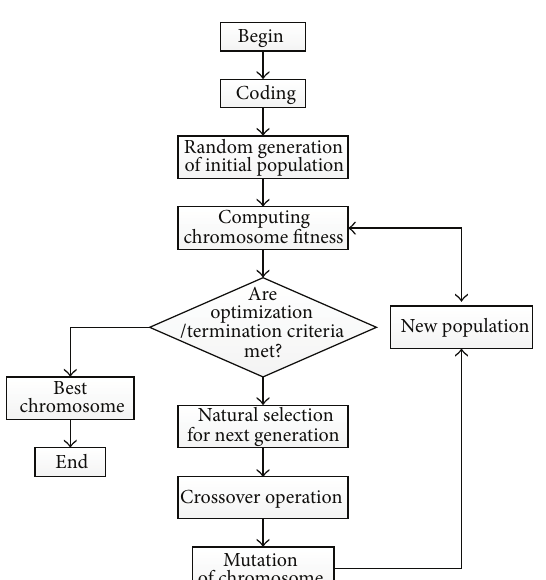
Figure 3: Flowchart of genetic